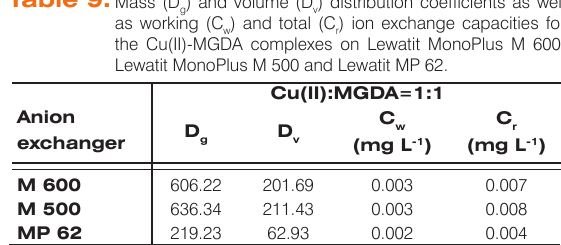
types e.g. complexation in the ion exchange phase or